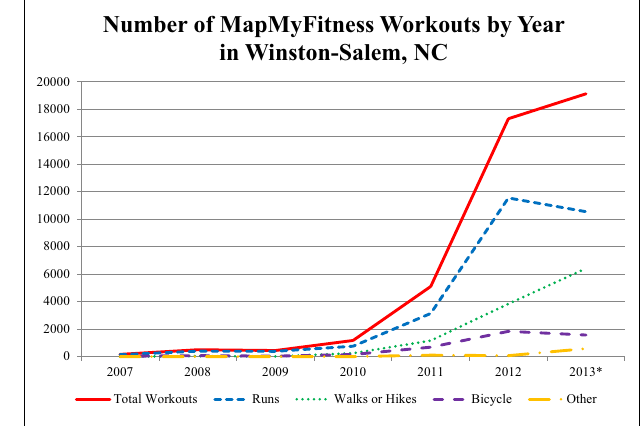
FIGURE 3 |Winston-Salem study area included in analysis (Davie, Davidson, Forsyth, Guilford, Rockingham, Stokes, Surry,Yadkin, and Randolph counties) . A sample of MapMyFitness points within the Winston-Salem study area, colored by whether they are in a park.